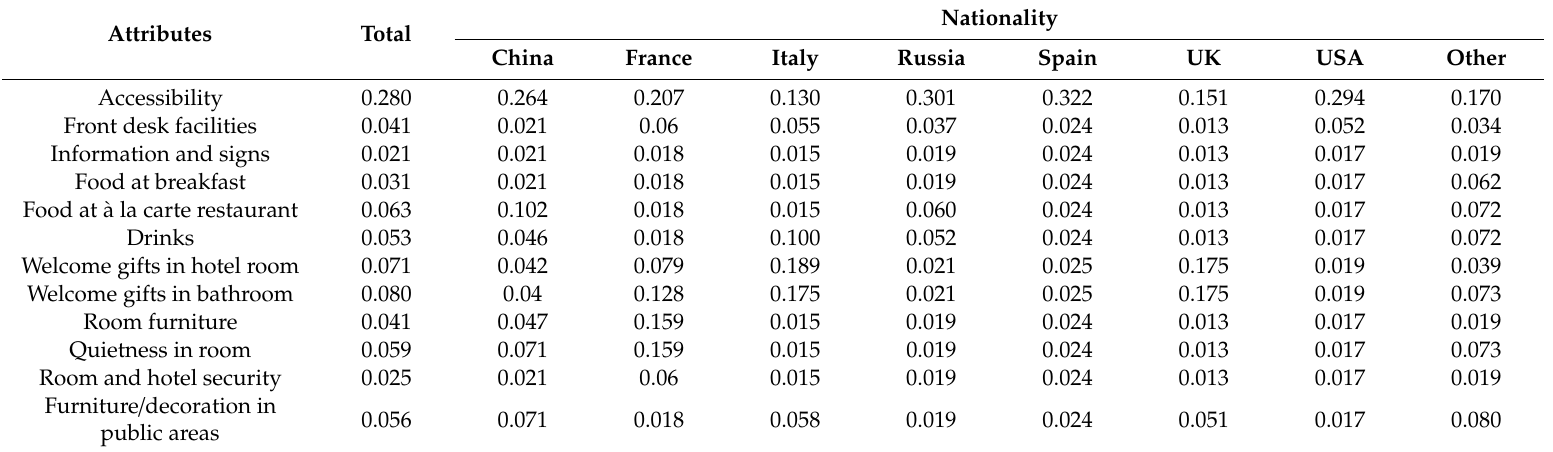
Table A3. Elasticities of Guests’ Satisfaction. Total and nationality. Four-Star